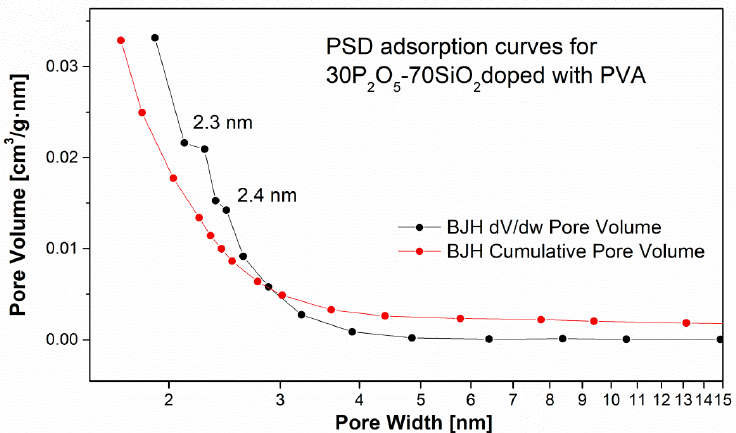
Figure 9. Pore size distribution vs. pore volume (incremental and cumulative) for 30P 2 O 5 -70SiO 2 + 0.5% PVA + 5% TiO 2 (TEOT) samples.